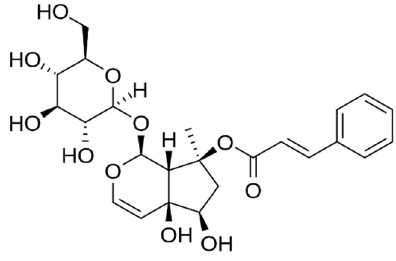
Figure 3. Chemical structure of harpagoside.